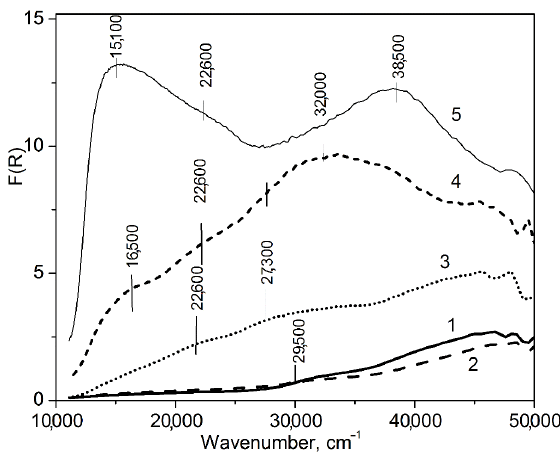
Figure 5. UV-Vis DR spectra of Cu-MFI-SST. The copper loadings are 0.5 (1), 1 (2), 2 (3) and 16 wt.% (4). For comparison, spectrum of CuO (5) is presented.